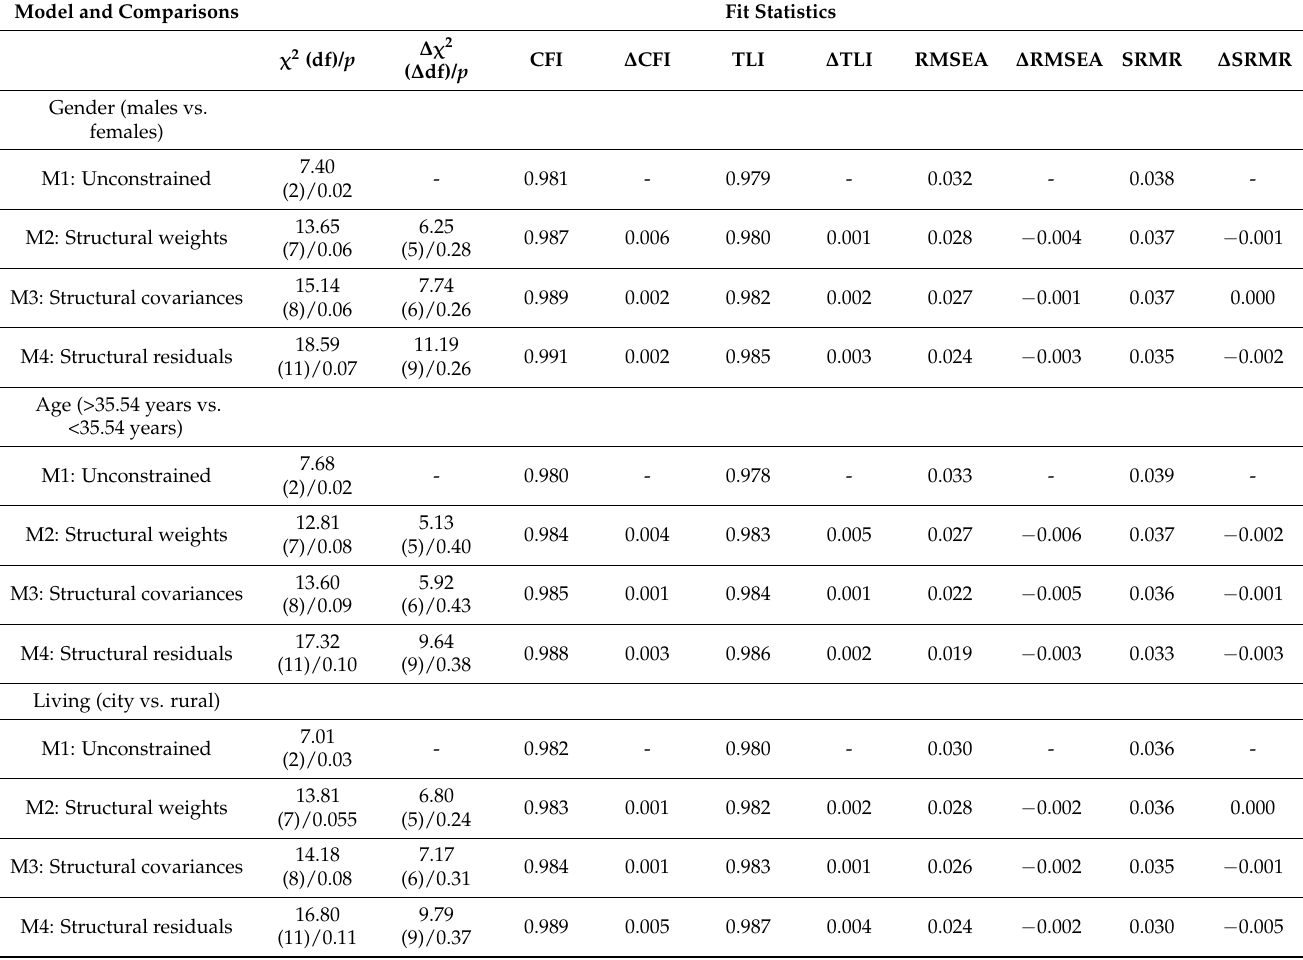
Table 3. Path invariance across age, gender, and living place through multigroup structural equation modeling